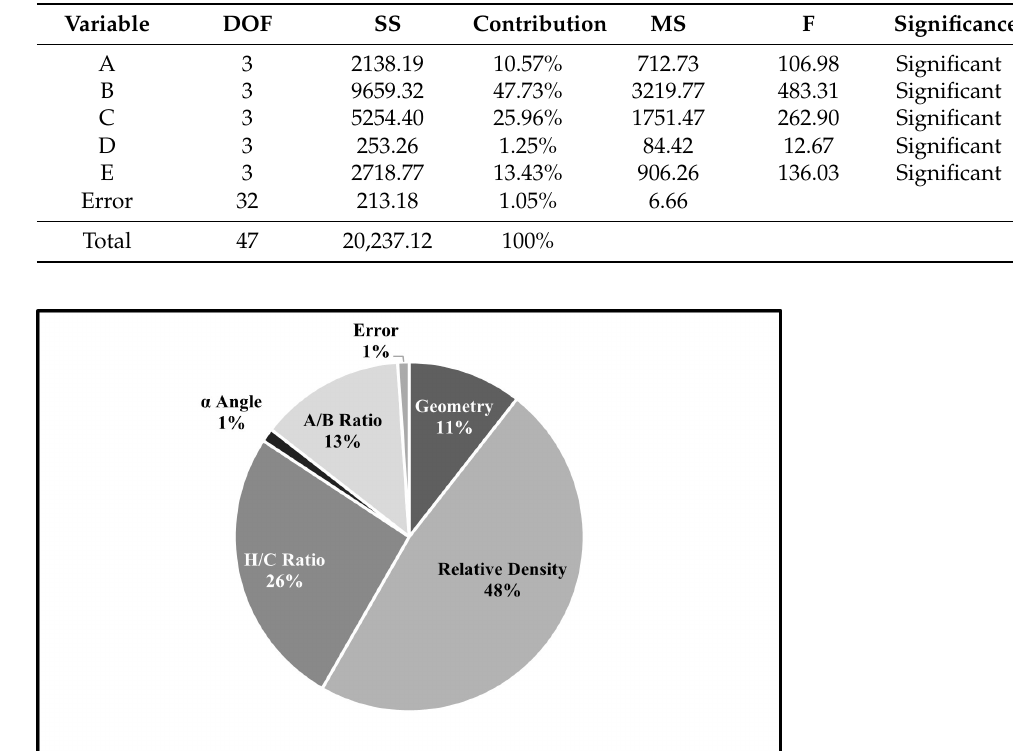
Figure 9. Contributions of Each Control Factor.